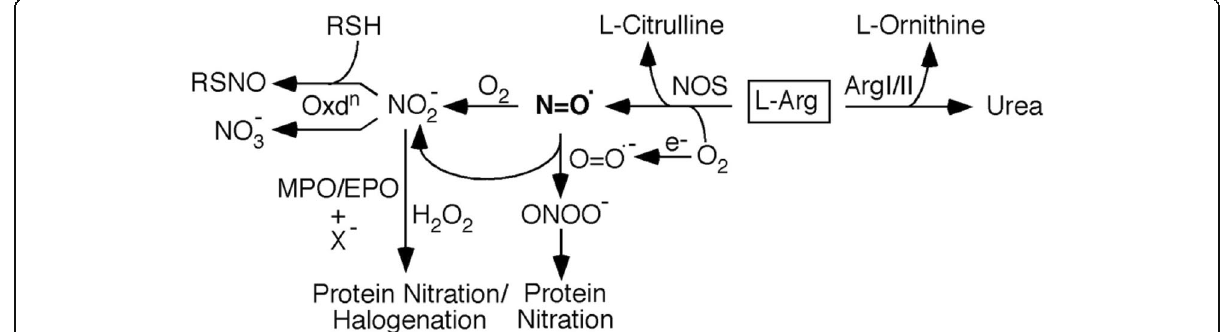
Fig. 1 Action of arginase and nitric oxide synthase on L